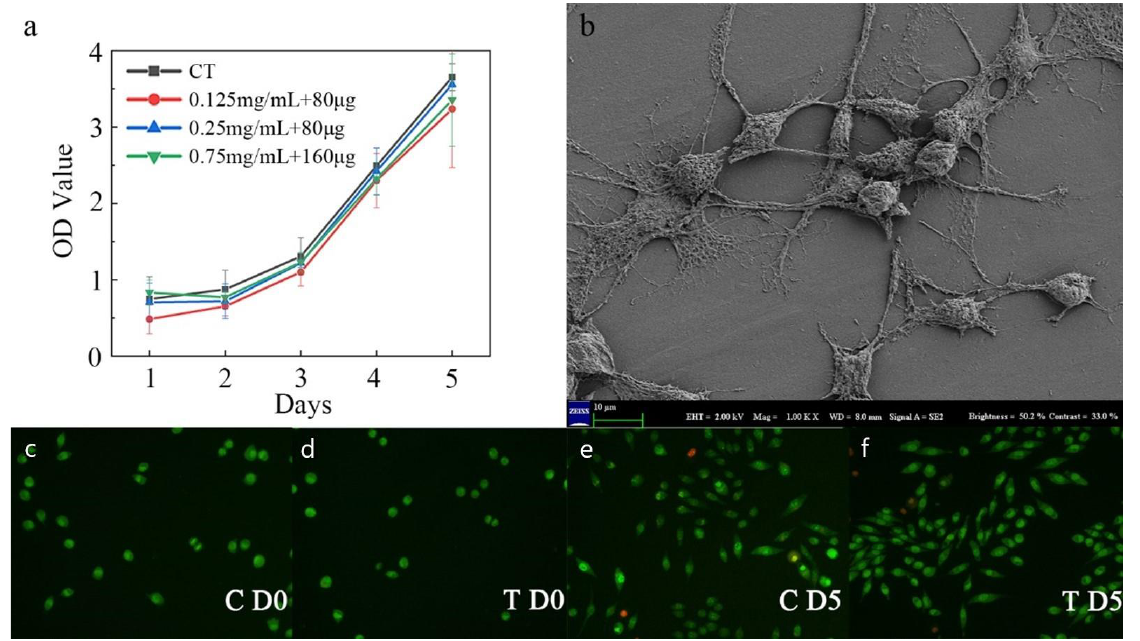
Figure 7. Characterization of fibrogenic performance. ( a ) The OD value of the control and minocycline conditions across 5 days. ( b ) SEM image of PLA substrate surface with fibroblast. ( c ) Live/dead staining for control on day 0. ( d ) Live/dead staining for minocycline condition on day 0. ( e ) Live/dead staining for control on day 5. ( f ) Live/dead staining for minocycline condition on day 5.